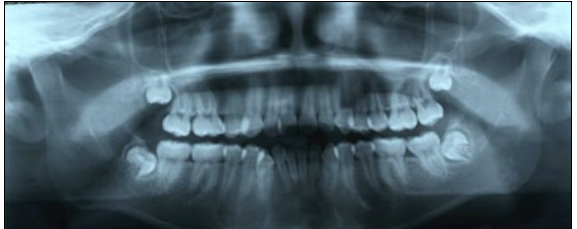
Figure 3. Pretreatment